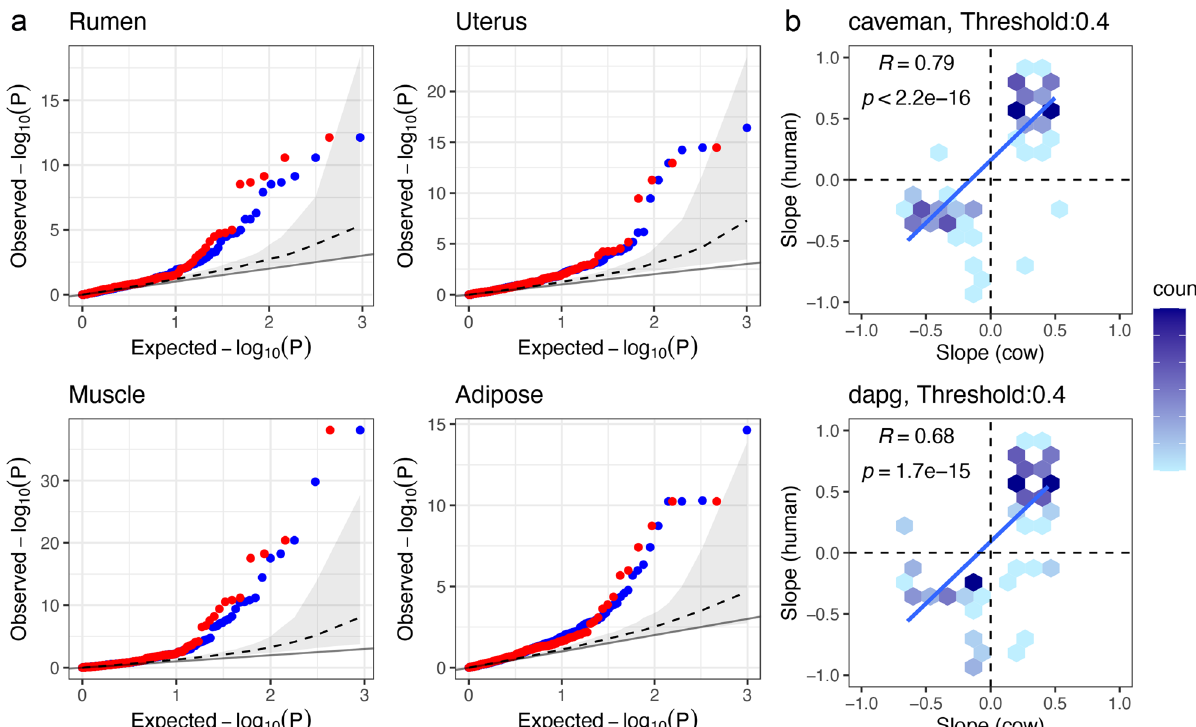
Fig. 6 Conserved effects of regulatory variants across humans and livestock. a Quantile-quantile (Q-Q) plots of observed and expected cis-eQTL P values of cattle variants that are direct orthologues of human fi ne-mapped regulatory variants. The blue points represent the observed and expected P values of the cattle variant ’ s association with the expression level of the cattle orthologue of the corresponding human gene in four cattle tissues irrespective of its allele change. The red points are the same after restricting to these variants exhibiting the same allele change as observed at the human SNP. The grey dashed line and grey ribbon represents the median and 95% con fi dence interval obtained when randomly sampling the same number of variants as shown by the blue points from all cattle variants tested (irrespective if have a known human orthologous variant or not) 1000 times. The line of parity (solid black) is also shown. This illustrates cattle orthologues of human fi ne-mapped regulatory variants are more likely to show evidence of also being linked to the orthologous gene ’ s expression across different tissues. b Comparison of the slopes (direction of effects) of eVariants across species. The slopes of human fi ne-mapped regulatory variants (using caveman or dap-g approach) were compared to the slopes observed for their orthologues if they also had a signi fi cant cattle GTEx association with the expression level of the orthologous gene in cattle. The slope represents the impact on the gene ’ s expression of increasing the dosage of the same allele in both species. Note the same eVariant can be found in multiple tissues and can therefore be represented multiple times in this plot. In total there are 83 and 106 human-cattle association pairs in the caveman and dapg plots, involving 43 and 57 distinct human eVariant-gene-tissue associations. The signi fi cant positive correlation remains if only one entry for each human eVariant-gene-tissue association is retained. This agreement in direction is seen despite not restricting to comparing the effects to the same tissues across species, i.e., the direction of effect is generally conserved across tissues as well as species. The data underlying this fi gure can be found in Supplementary Data